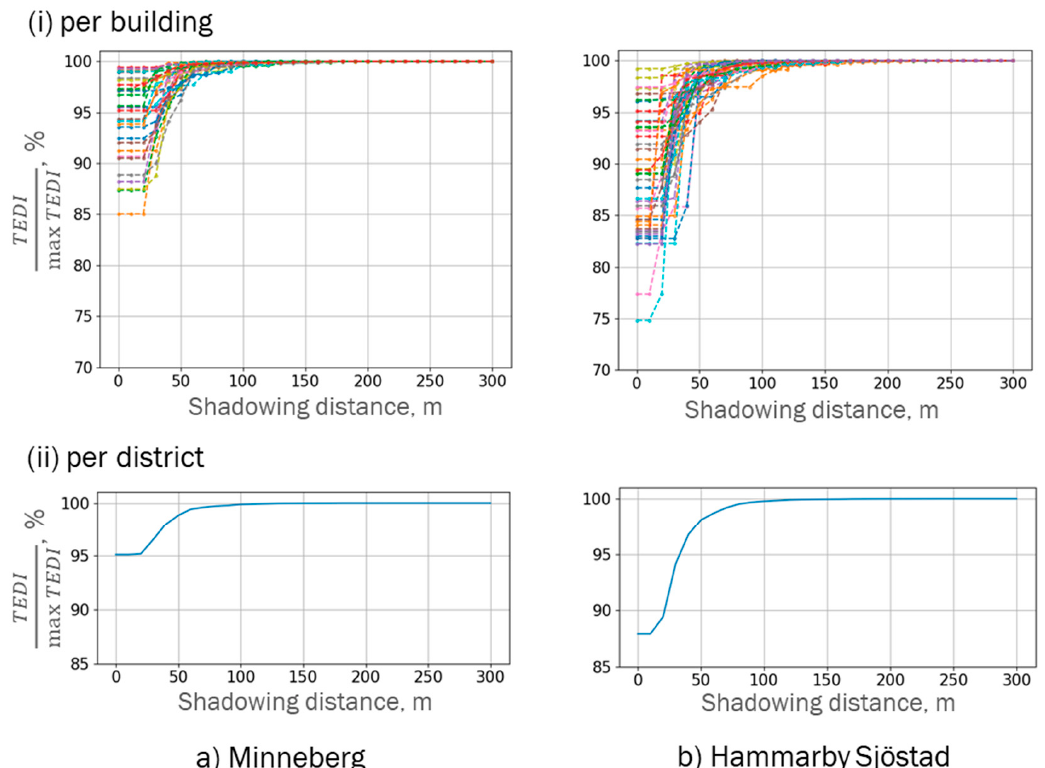
Figure 13. Impact of shadowing environment limited by a distance threshold on thermal energy demand intensity (TEDI) for each building (top) and the entire district (bottom) in ( a ) Minneberg and ( b ) Hammarby Sjöstad districts. Maximum TEDI was used as the